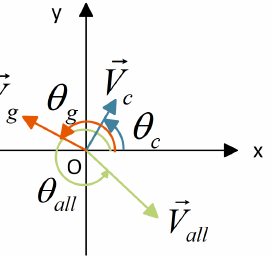
−→ V c , HAUV speed vector